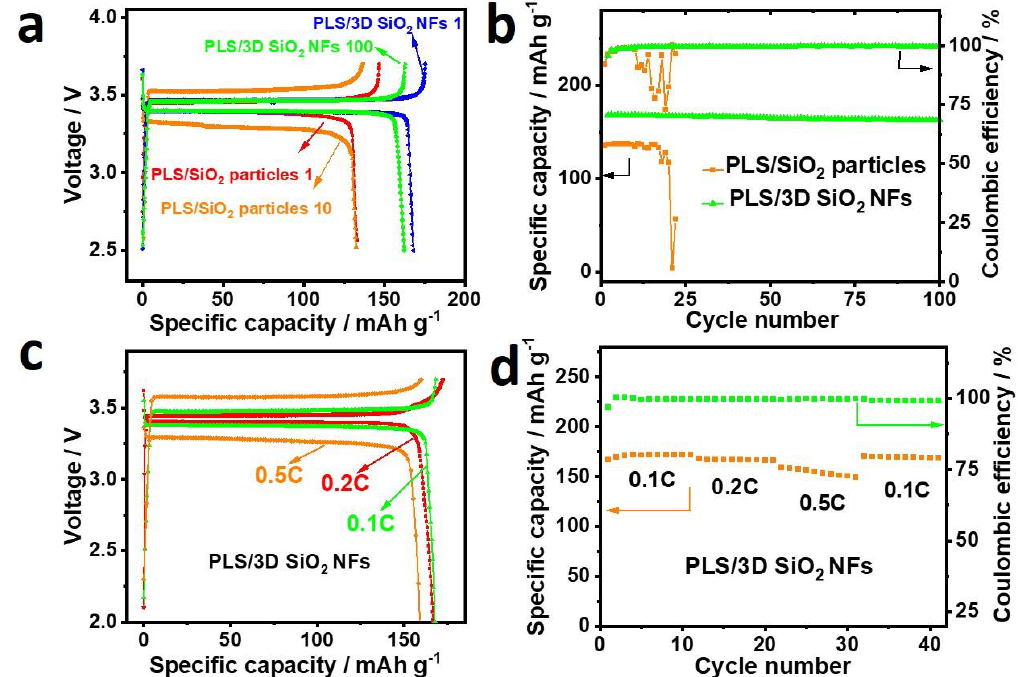
Figure 5. Charge and discharge curves ( a ) and cycling performance ( b ) of Li | PLS / SiO 2 particles | LiFePO 4 (LFP) and Li | PLS / 3D SiO 2 NFs | LFP. Charge and discharge curves ( c ) and rate performance ( d ) of Li | PLS/3D SiO 2 NFs | LFP.